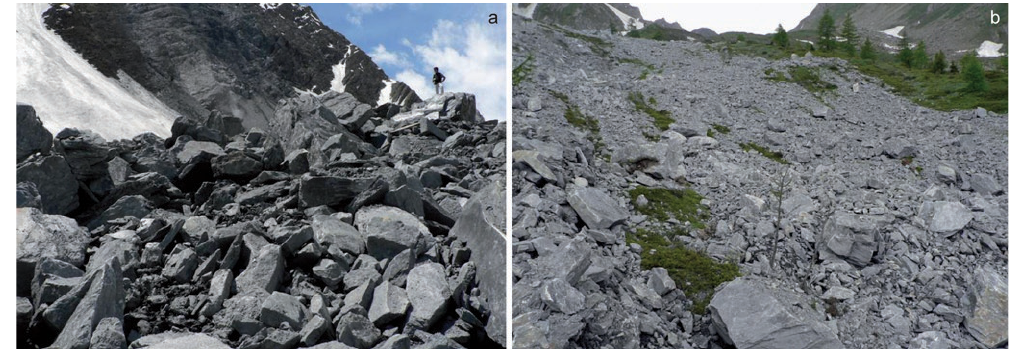
Fig. 9. Final rock deposit of the rock avalanche on the plateau, after the melting of the snow (June 2009). (a) several-m-thick deposit in the lower centre of the east arm; (b) scoured areas in the west arm.